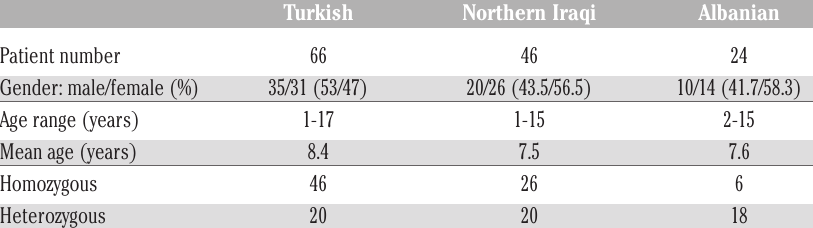
Table 1. Patient characteristics.